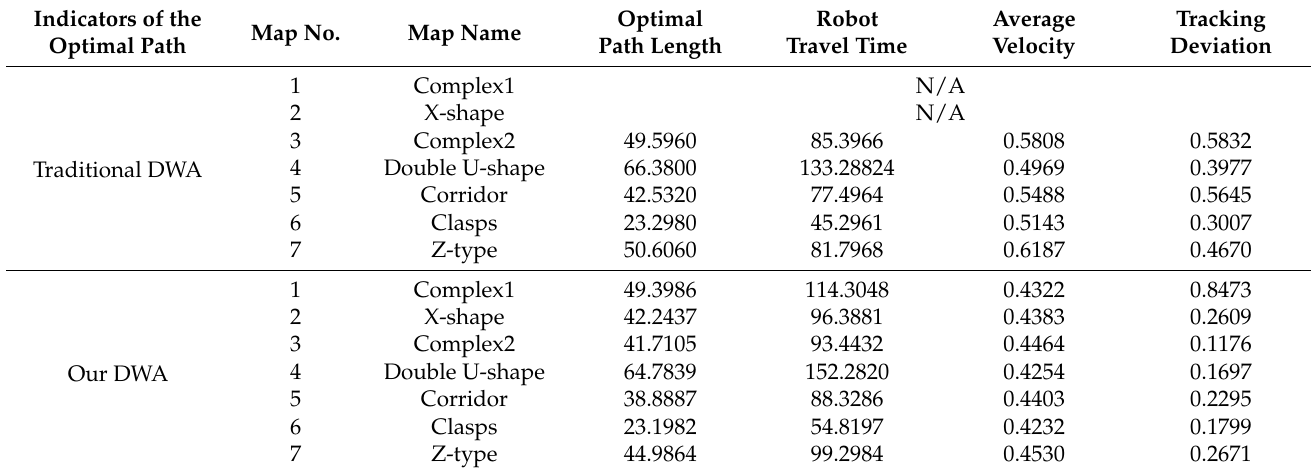
Table 6. Comparison of the results of the two algorithms in local path